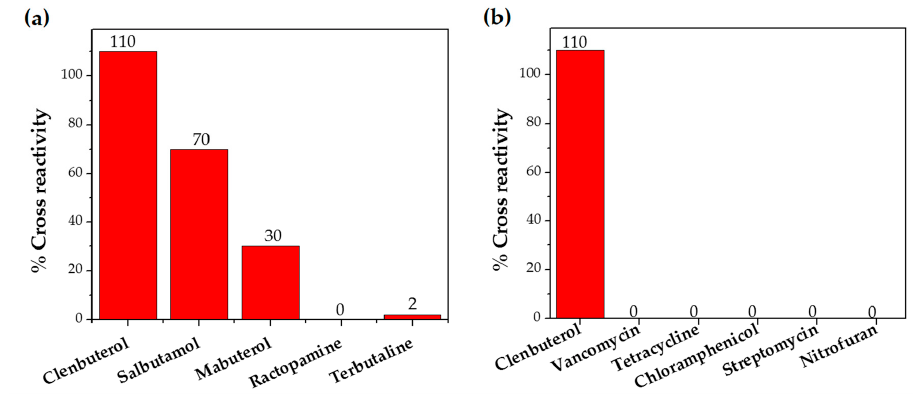
Figure 6. Cross-reactivity of the polyclonal anti-CLB antibody with; ( a ) antibiotics from β -agonist family and ( b ) antibiotics form other groups. Table 1. Antibiotic structures.